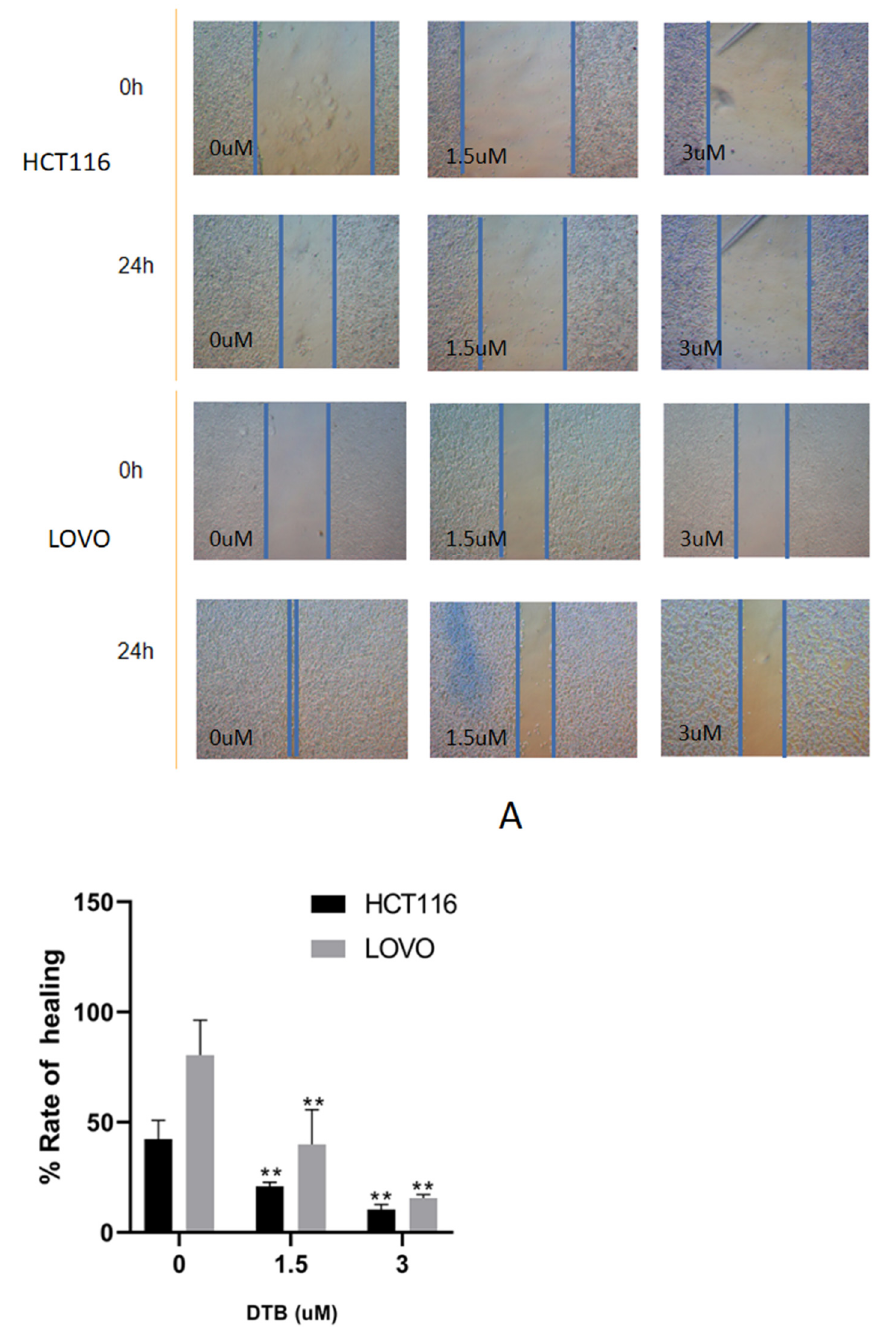
Figure 4. ( A ) The effect of different concentrations of DTB on the wound healing of HCT116 and LOVO cells under the microscope (×40). ( B ) The effect of DTB on the wound healing rate of colon cancer. n = 3; each data point represents the mean ± standard error. Compared with the blank group, ** p < 0.01.